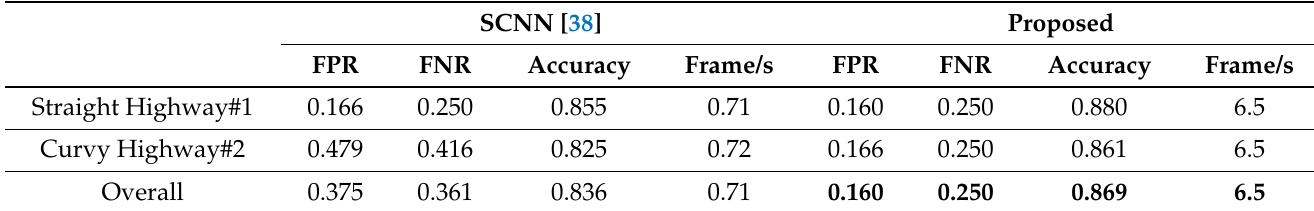
Table 4. Proposed approach compared with one of the deep-learning-based models